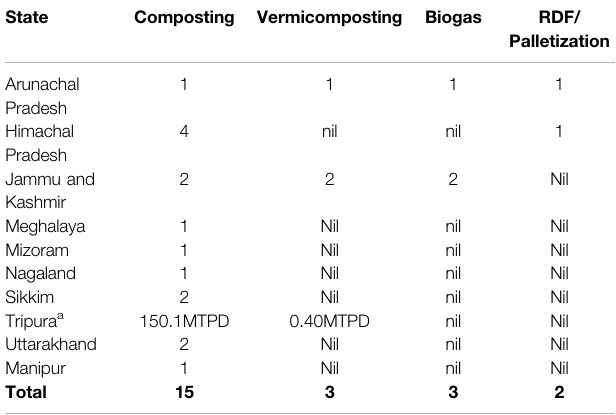
TABLE 2 | A number of solid waste processing facilities operational in the IHR states (Data Source: CPCB, 2019). A total of 15 composting,